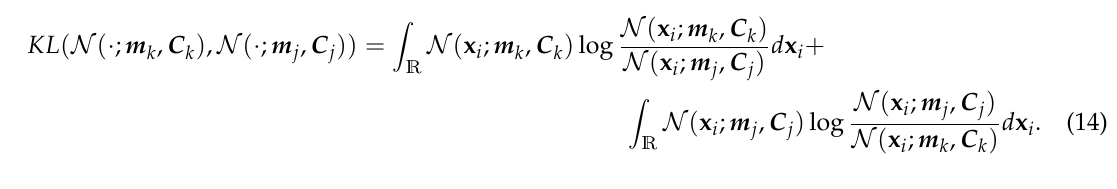
Table 1. Kullback–Leibler divergence between cluster densities and proportions for each cluster.